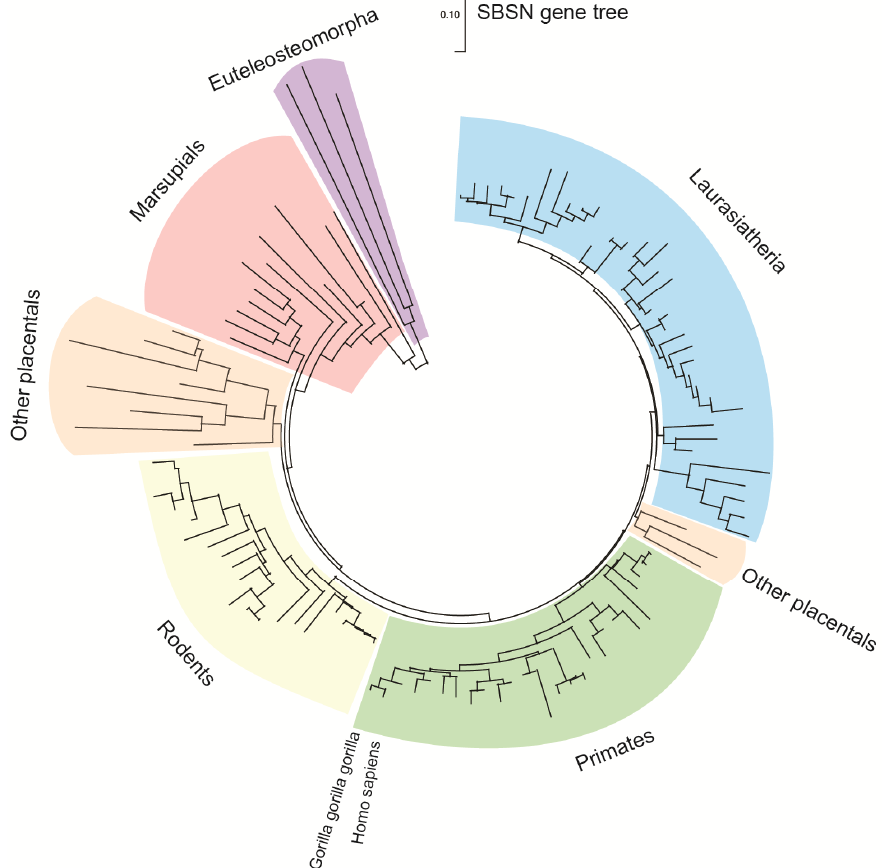
Figure 1. The gene tree of suprabasin SBSN . The gene tree of SBSN generated with MEGA X software [4] utilizing Enesembl (version 101) available data [3]. With the total sum of branch lengths (SBL) being >9.477. Distance scale = 0.10.